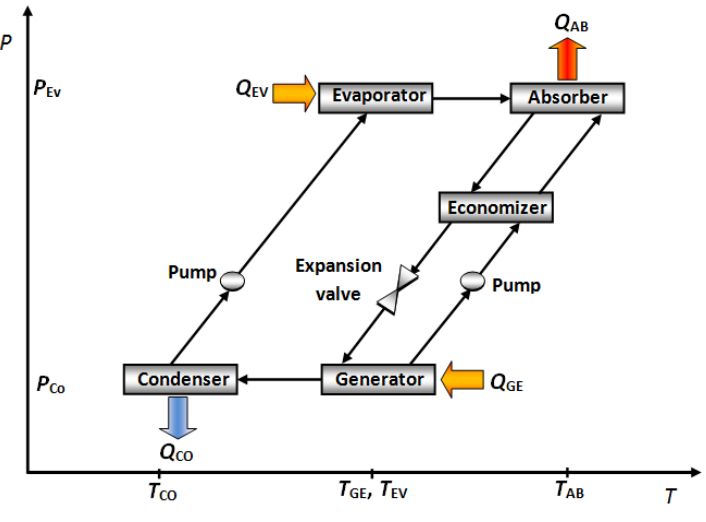
Figure 5. Schematic diagram of an Absorption Heat Transformer